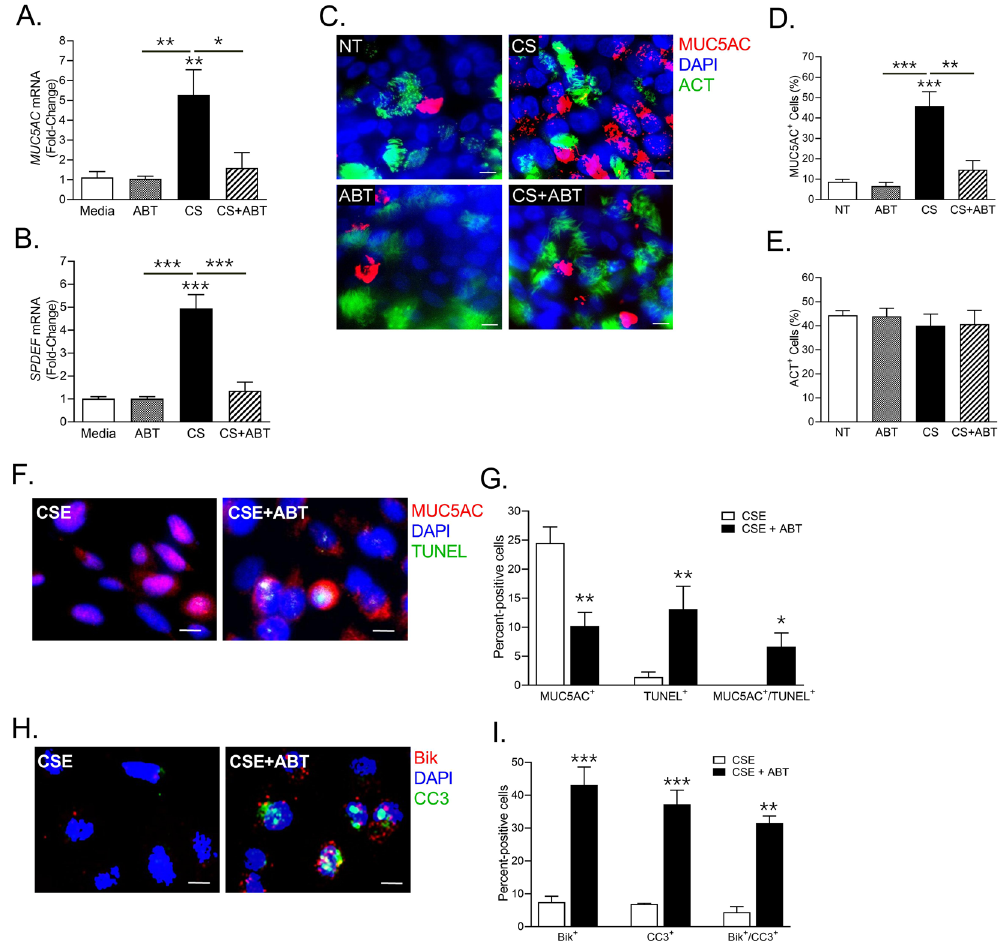
Figure 5. BH3 mimetic ABT-263 blocks the CS-induced mucous phenotype in 3-D human airway tissue model via inducing apoptosis and Bik expression. 3-D tissue cultures of human airways were exposed to CS using a SCIREQ smoke machine (Montreal, QC, Canada) for 3 consecutive days and one group was treated with 1 µ M ABT-263 2 h before exposures. ABT-263 treatment inhibited the CS-induced MUC5AC ( A ) and SPDEF ( B ) mRNA expression. ( C ) Representative micrographs showing cilia (green) and MUC5AC (red) immunopositivity in 3-D airway tissue culture treated with CS and/or ABT-263 compared to non-treated (NT) ones. 3-D airway tissues were immunostained for acetylated-tubulin (ACT, in green) for cilia and MUC5AC (red), and nuclei were stained with DAPI (Scale – 5 µ ). Quantification of MUC5AC + mucous cells ( D ) and ACT + ciliated cells ( E ) where more than 300 cells from each treatment were analyzed. ( F ) ABT-263 treatment results in increased TUNEL-positivity in CSE-exposed human AECs. Human AECs treated with ABT-263 (1 µ M) and/or CSE (10 µ g/ml) were stained for TUNEL (green) and MUC5AC (red). ( G ) Quantification of human AECs immunopositive for MUC5AC (MUC5AC + ) or TUNEL (TUNEL + ) or both (MUC5AC + / TUNEL + ) following ABT-263 and CSE treatment. ( H ) ABT-263 increases Bik expression and caspase 3 activation in CSE-exposed AECs. Human AECs were immunostained for Bik (red) and cleaved caspase 3 (CC3, shown in green). ( I ) Quantification of human AECs immunopositive for Bik (Bik + ) or CC3 (CC3 + ) or both (Bik + /CC3 + ) following ABT-263 and CSE treatment. Data shown as mean ± SEM (n ≥ 3); * p < 0.05; ** p < 0.01; *** p <